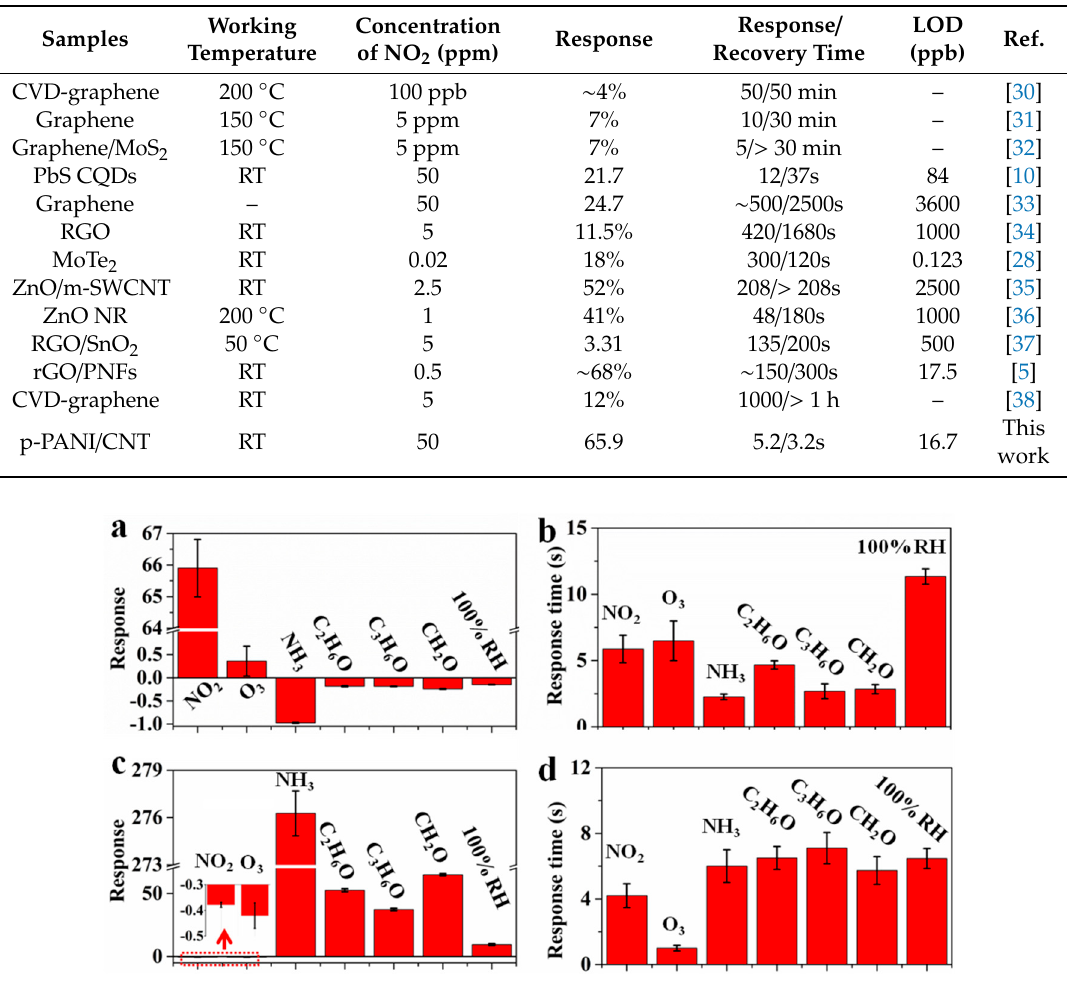
Figure 6. ( a ) Responses, ( b ) response time of p-PANI/CNT and ( c ) responses, ( d ) response time of n-PANI/CNT to 50 ppm of NO 2 and NH 3 , 100 ppm of O 3 , C 2 H 6 O, C 3 H 6 O, CH 2 O and 100% RH.